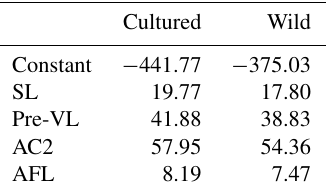
Table 3. Fisher’s discriminant functions for morphometric vari-